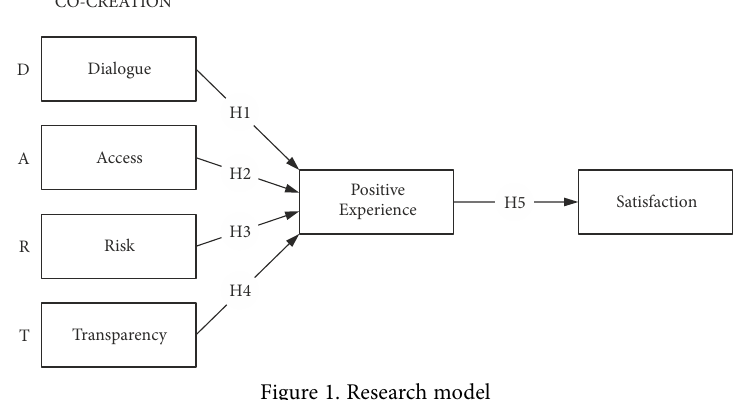
Figure 1. Research